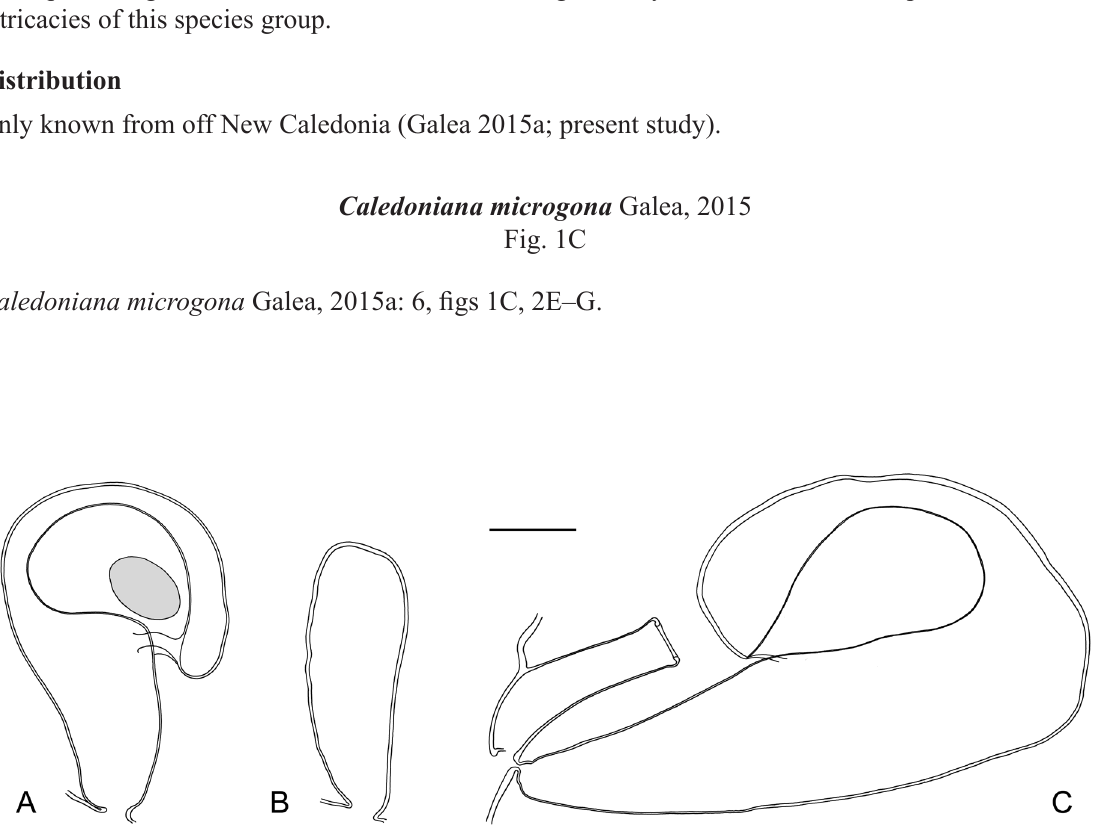
Fig. 1. A–B . Caledoniana decussata Galea, 2015, female (MNHN-IK-2015-361) and male (MNHN- IK-2015-362), gonothecae. — C . Caledoniana microgona Galea, 2015, female gonotheca arising from below base of hydrotheca (MNHN-IK-2015-363). Scale bar: 1